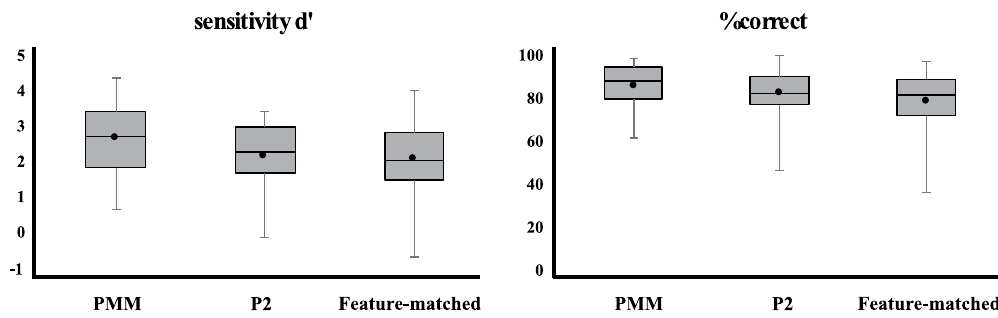
Figure 2. Behavioral performance. Percent correct for discriminating pattern exemplars and average d ′ across 18 participants are shown. Black lines indicate the median while black dots indicate the mean. Error bars show variability outside the